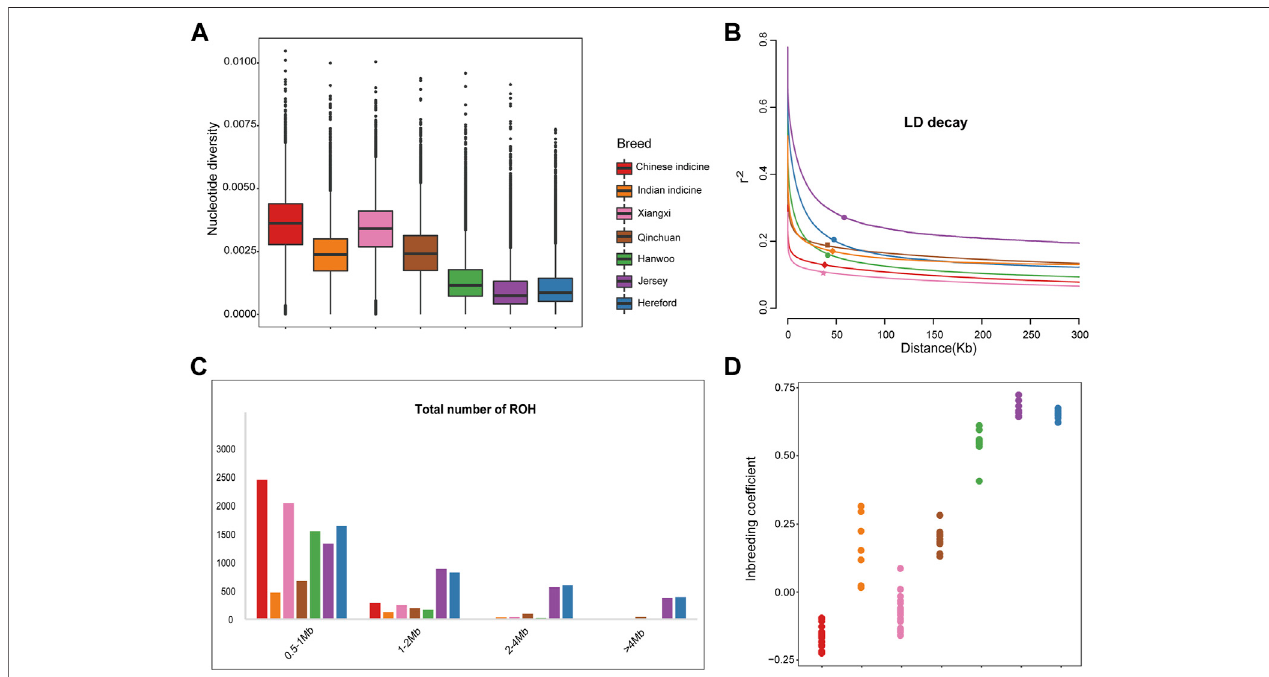
FIGURE2| Geneticdiversityamong101samplesfrom7populations. (A) Boxplotsofthenucleotidediversityforeachgroup.Thepointswhichwereontheoutside the of whiskers showed outliers (B) Decay of linkage disequilibrium on cattle autosomesestimated from each breed. (C) The estimation of total number ofROHfor each group (D) Inbreeding coef fi cient for each